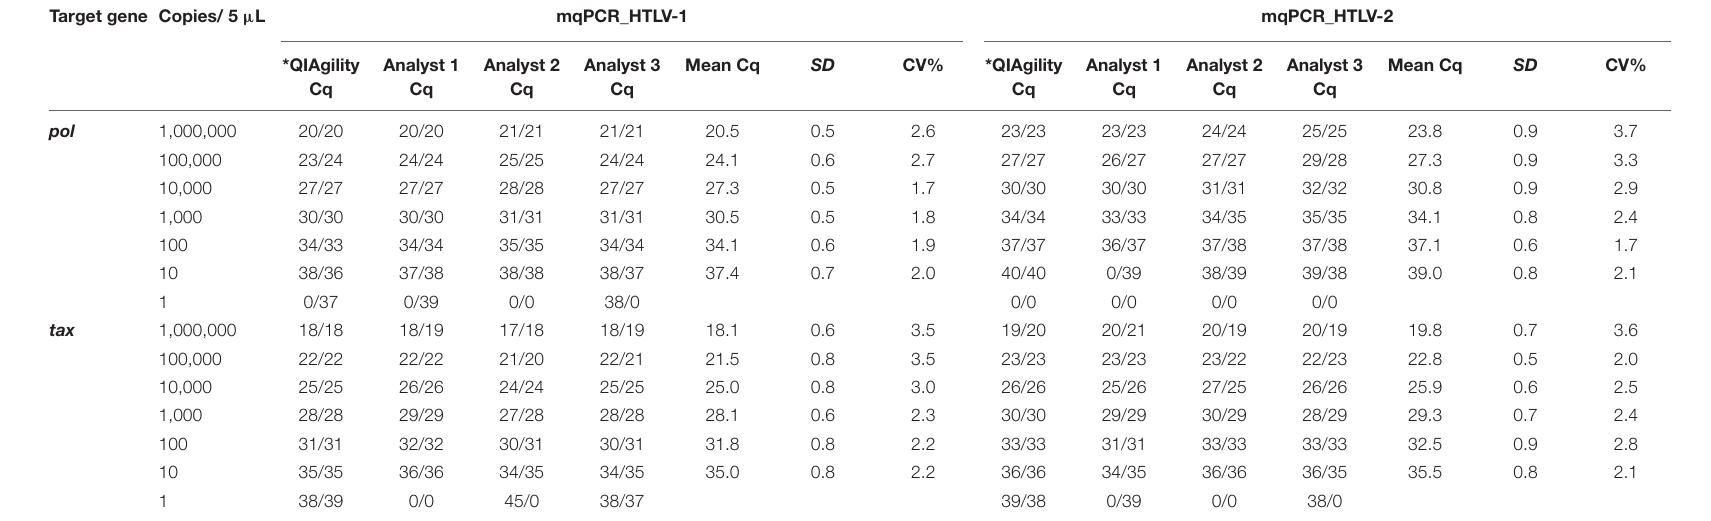
*QIAgility, robotic PCR setup; SD, standard deviation; CV, coefficient of variation (calculated between non-zero